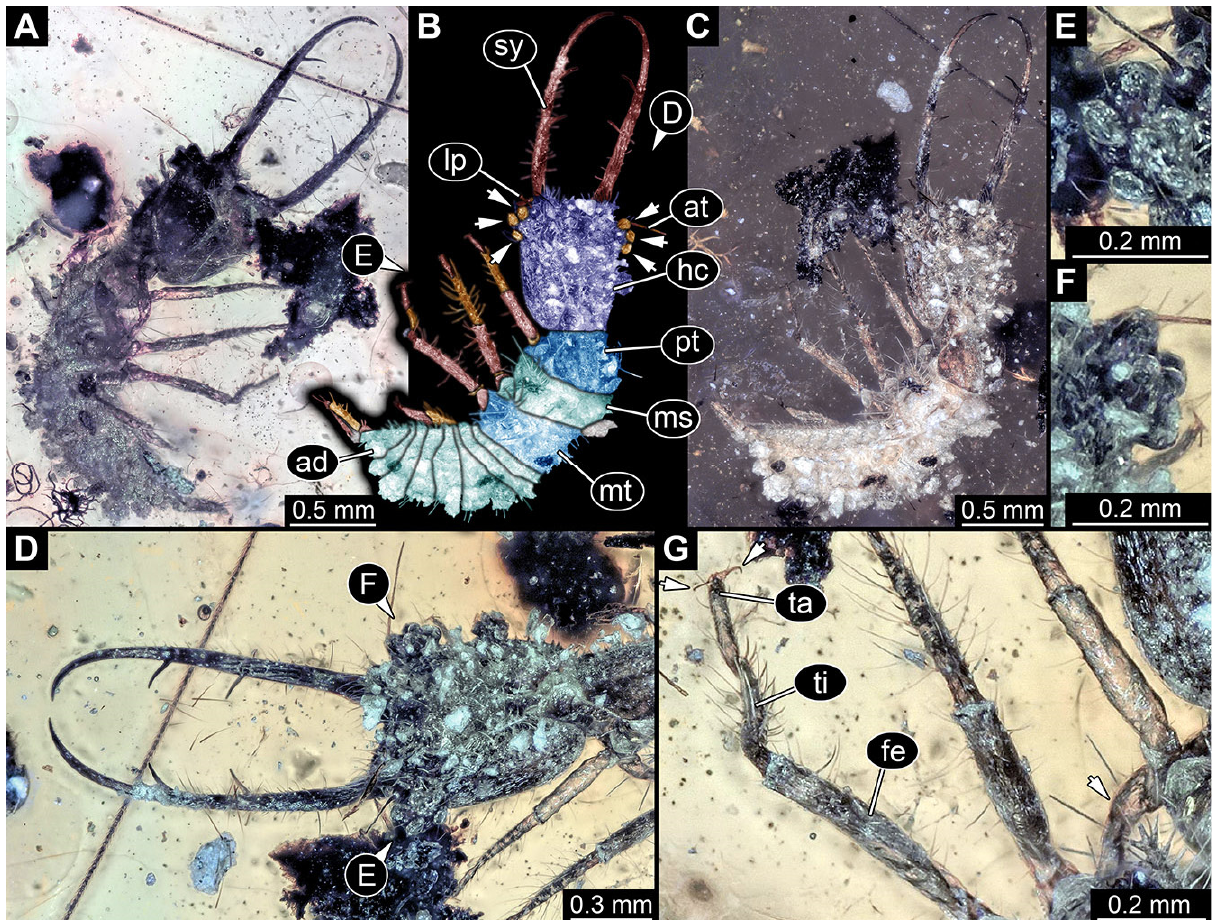
Figure 9. Fossil owllion larva, specimen 3221 (BUB unnumbered), Cretaceous Kachin amber, Myanmar. ( A ) Overview, oblique ventral. ( B ) Color-marked version of ( C ); arrows mark stemmata. ( C ) Overview, oblique dorsal. ( D ) Close-up on head capsule. ( E , F ) Close-ups on fields of stemmata. ( G ) Close-up on locomotory appendage, with claws (left arrows) and dorsal process (right arrow). Abbreviations: ad = abdomen; at = antenna; fe = femur; hc = head capsule; lp = labial palp; ms = mesothorax; mt = metathorax; pt = prothorax; sy = stylet; ta = tarsus; ti = tibia. 10. Specimen 3222 (BUB 3062), preserved in Cretaceous Kachin amber, Myanmar. Spec-